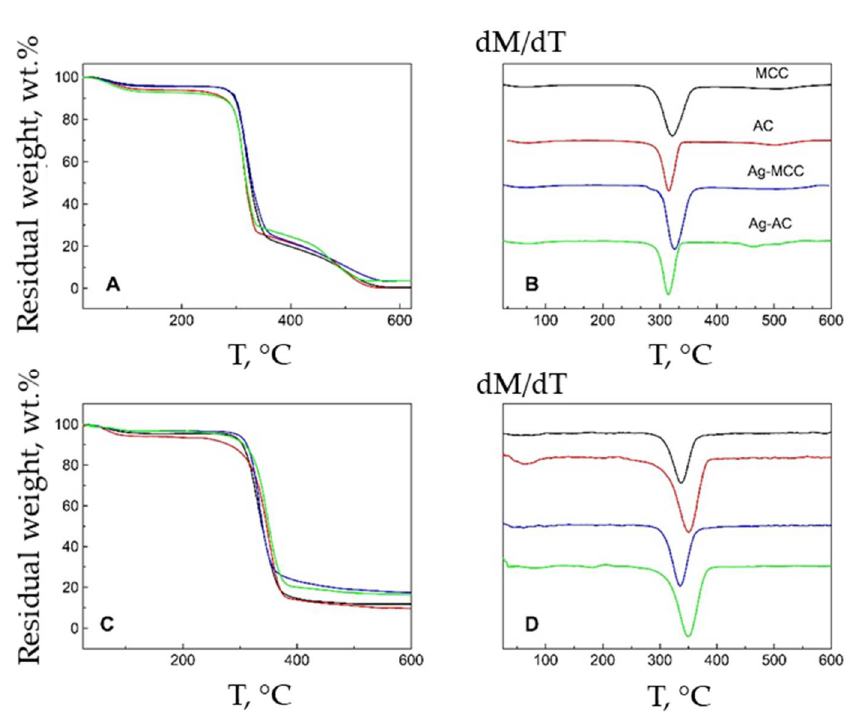
Figure 14. TG and DTG curves for MCC (black), AC (red), Ag-MCC (blue) and Ag-AC (green) in air ( A , B ) and argon atmosphere ( C , D ) at a heating rate 10 °C/min.